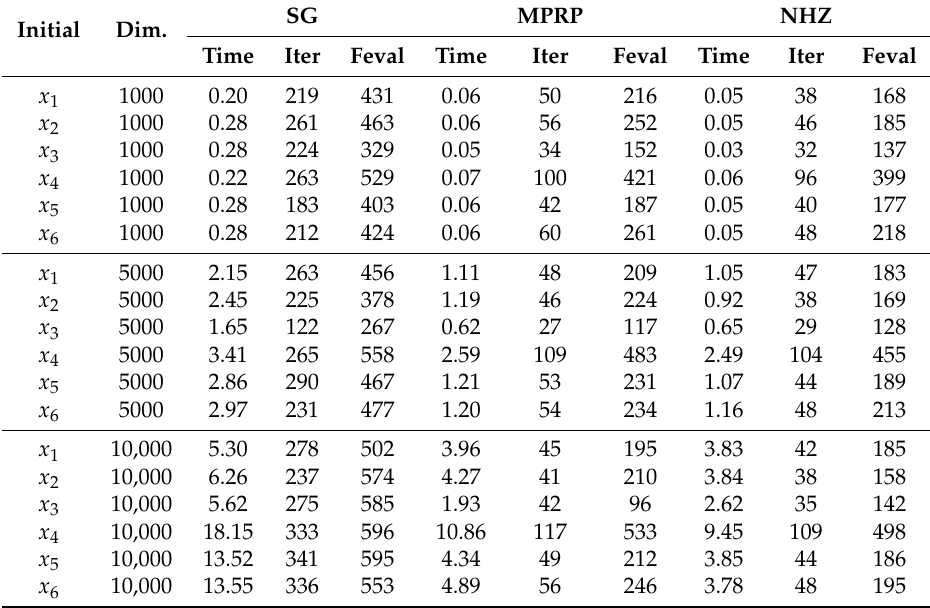
Table 4. Numerical results for the tested Problem 4 with various sizes and given initial points.